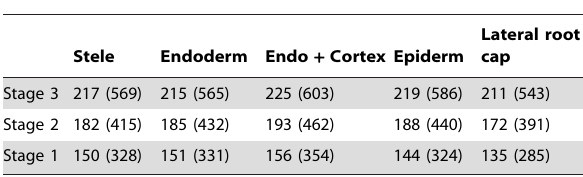
Table 1. The spatiotemporal variation of active